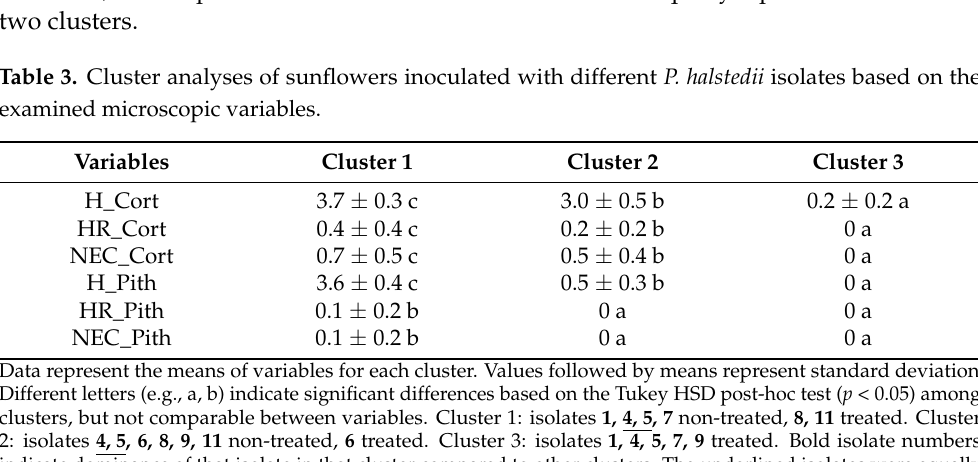
Data represent the means of variables for each cluster. Values followed by means represent standard deviation. Different letters (e.g., a, b) indicate significant differences based on the Tukey HSD post-hoc test ( p < 0.05) among clusters, but not comparable between variables. Cluster 1: isolates 1, 4, 5, 7 non-treated, 8, 11 treated. Cluster 2: isolates 4, 5, 6, 8, 9, 11 non-treated, 6 treated. Cluster 3: isolates 1, 4, 5, 7, 9 treated. Bold isolate numbers indicate dominance of that isolate in that cluster compared to other clusters. The underlined isolates were equally represented in the clusters